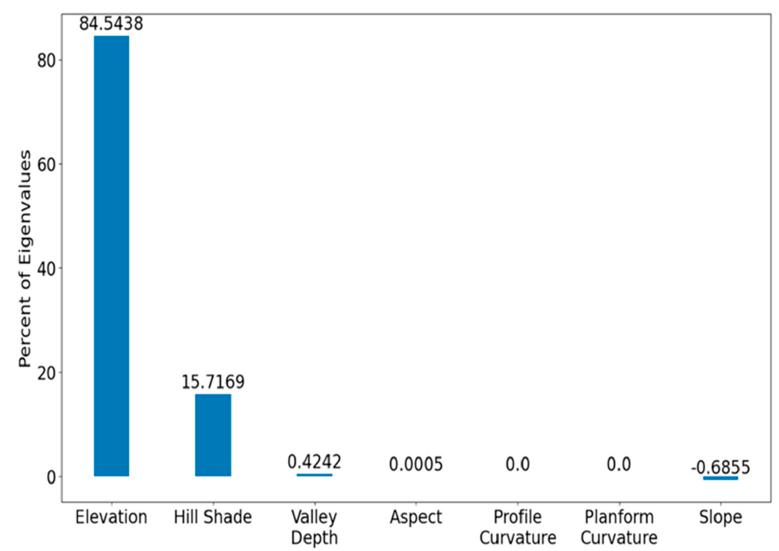
Figure 22. Principal component analysis of various topographic metrics within Carolina Bay detections.